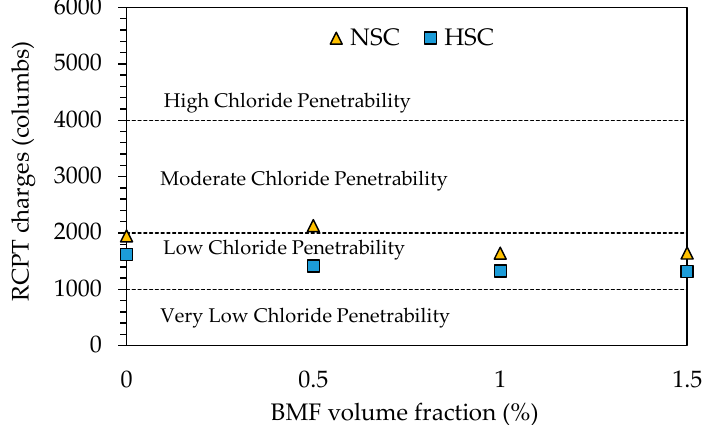
Figure 20. RCPT electrical charges versus BMF volume fraction relationship.